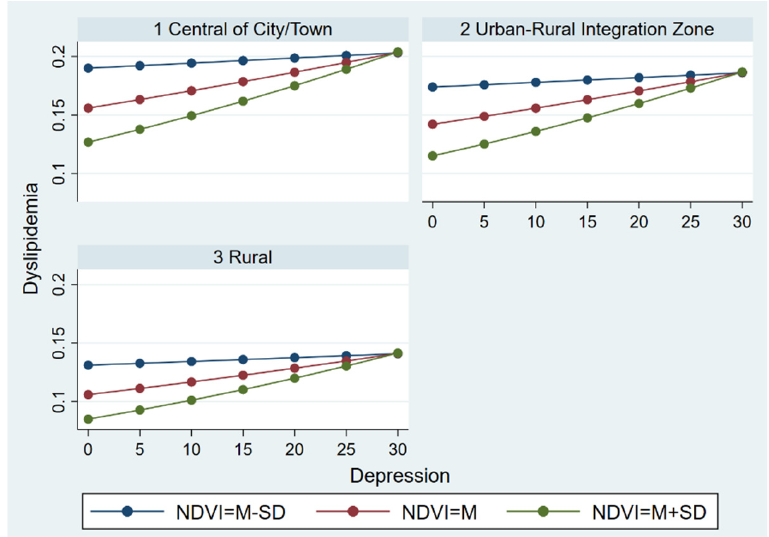
Figure 7. The moderate effect of NDVI on the relationship between depression and dyslipidemia across residence groups.